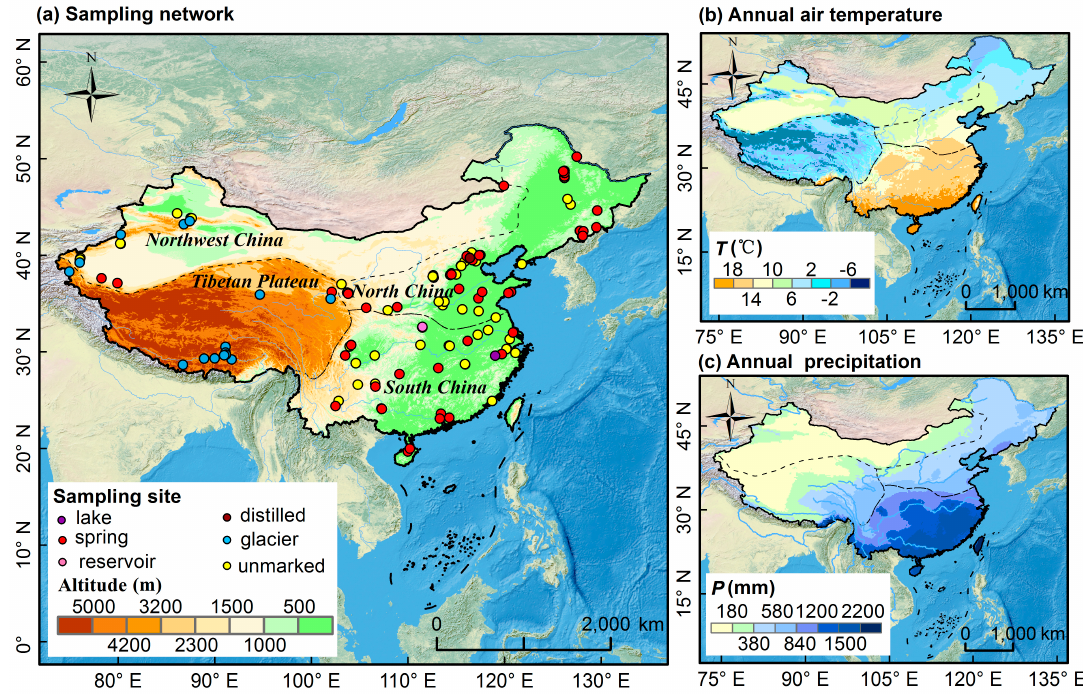
Figure 1. ( a ) Spatial distribution of sampling sites of bottled water in China. The digital elevation model is derived from Global 30 Arc-Second Elevation (GTOPO30; https://lta.cr.usgs.gov/GTOPO30 ). Based on natural regionalization in China [21], the four natural sub-regions of China (Northwest China, North China, South China and the Tibetan Plateau) are shown by dashed grey lines. The satellite-derived land cover base map is from Natural Earth (http://www.naturalearthdata.com). Spatial distribution of annual mean air temperature ( b ) and precipitation amount ( c ) in China during 1970–2000, derived from the WorldClim-Global Climate Data version 2 ([22]; http://worldclim.org/version2). The six different dot colors in ( a ) represent the different origins of our bottled water samples.